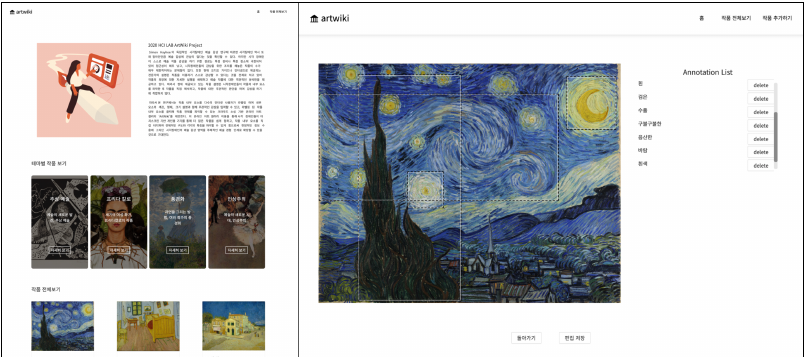
Figure 4. Screenshot examples of the main page ( left ) and edit page ( right ) of AccessArt